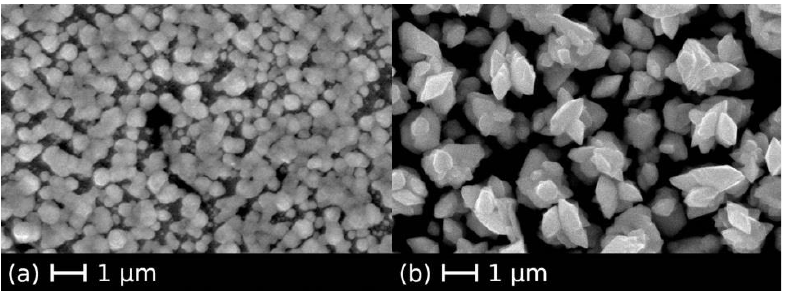
Figure 2. Micrographs of the Ag films obtained using ( a ) sulfite electrolyte on a glass/ITO/Au sub- strate, E d ~ − 0.1 V to Ag|AgCl|KCl(sat.), and ( b ) rhodanic electrolyte on the surface of glass/ITO/Au substrate, potential of deposition~ − 0.27 V to Ag|AgCl|KCl(sat.).